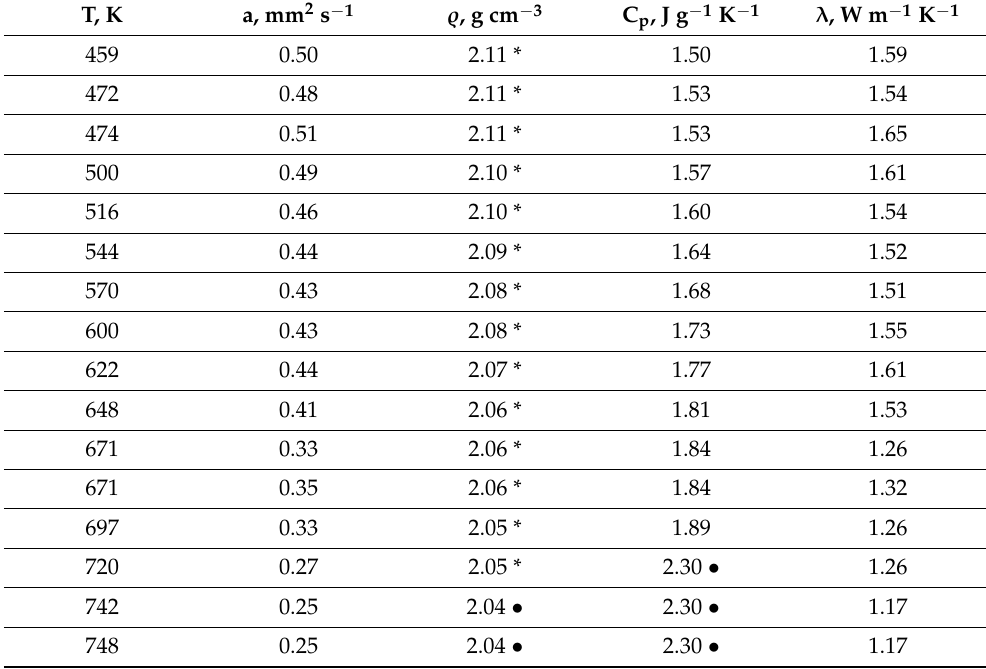
Table 1. Values of thermal diffusivity (a), density; ( (cid:36) ), heat capacity; (C p ); and thermal conductivity ( λ ) of the Li 2 BeF 4 compound.